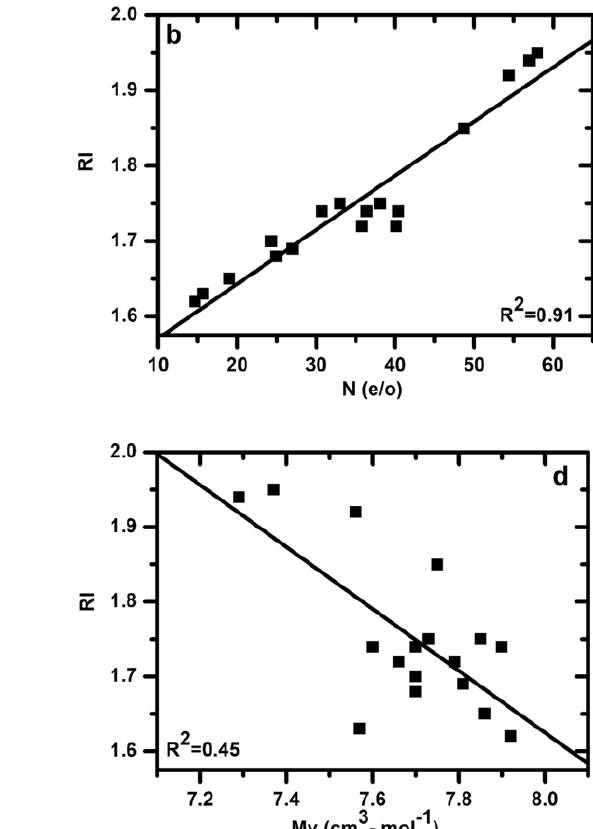
Figure 5. Left panel: ( a ) Glass refractive index as a function of atomic packing density ( c ) relation between refractive index and density. Right panel: ( b ) glass refractive index as a function of nitrogen content (in e/o) ( d ) relation between refractive index and molar volume for Ca – Si – O – N glasses.